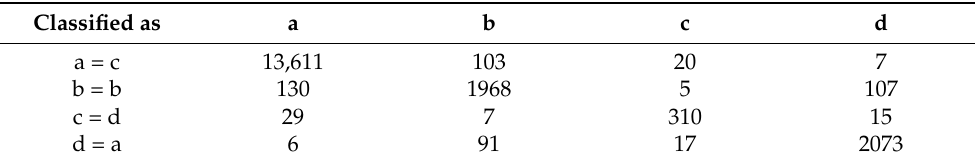
Table A2. The confusion matrix for main propulsion engine specific fuel oil consumption set as outlet variable.